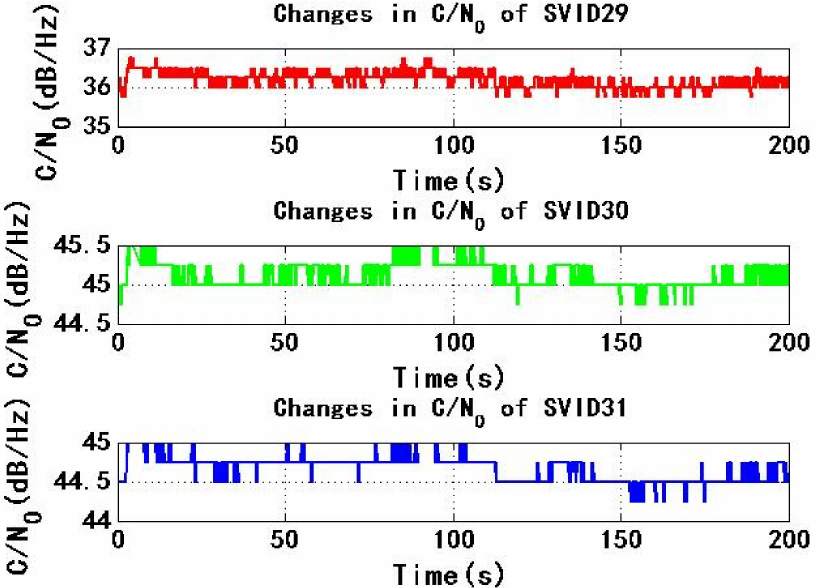
Figure 10. Changes in C / N 0 of SVID29, 30, 31 in experiment 1.